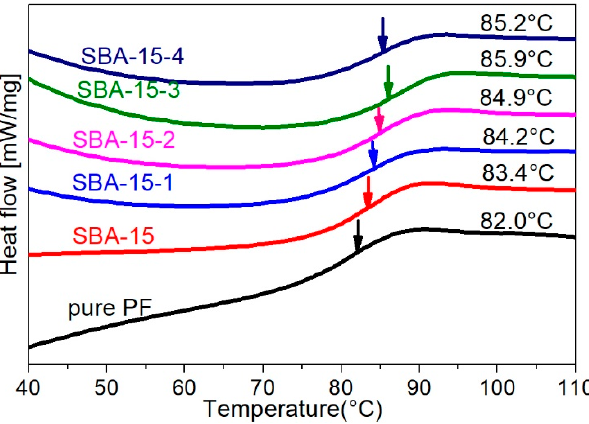
Figure 5. DSC curves and T g values for pure PF and SBA-15/PF